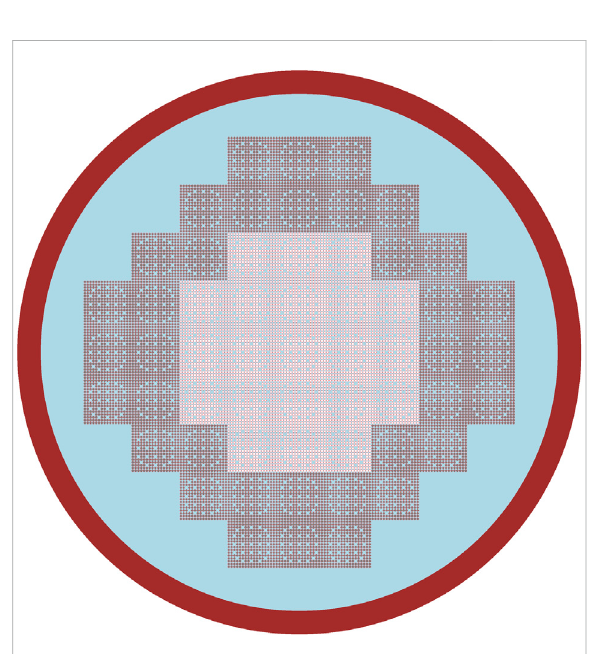
FIGURE 4 Updated OpenMC model of the SMART reactor core to have two enrichment levels (2.4 and 4.8%) for fuel